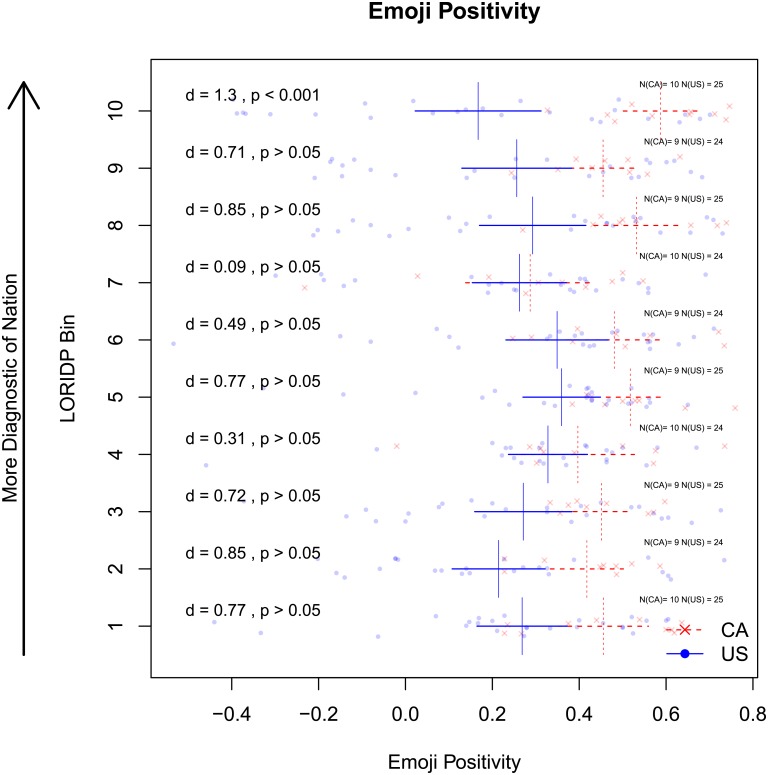
Positivity of Canadian and American emojis by LORIDP bin.Relative Positivity of very American (blue) versus very Canadian (red) emojis. Vertical lines indicate mean positivity of American and Canadian words in each bin. Horizontal lines are 95% confidence intervals of the means. Cohen’s d and p-values for t-tests within each bin are reported in the left of the fig. Canadian emojis are consistently more positive across the LORIDP distribution, but not reliably.